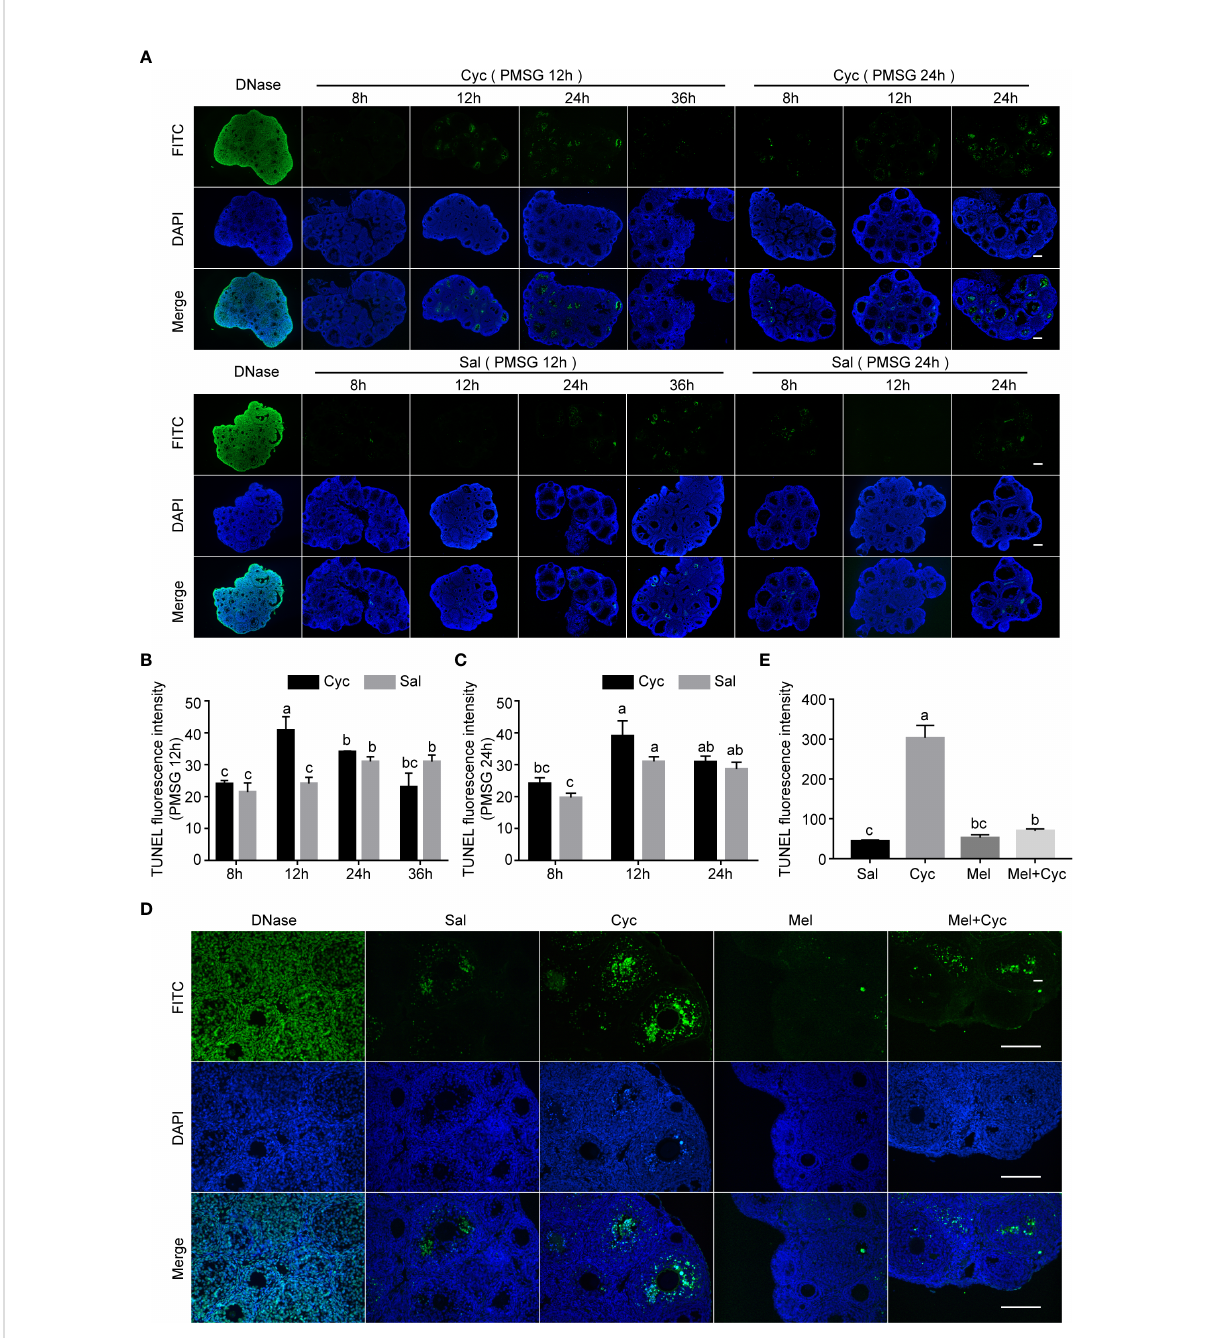
FIGURE 4 Cyc induced apoptosis of granulosa cells in growing follicles and Mel prevented this apoptosis. (A) Three-week-old ICR mice were injected i.p. with Cyc 12 or 24 h after injection of PMSG, and apoptosis in ovarian tissues was detected by TUNEL kit at 8, 12, 24, and 36 h after Cyc injection. Regardless of whether Cyc was injected 12 or 24 h after PMSG injection, apoptotic peak of granulosa cells in ovary appeared 12 h after Cyc intervention, which was not related to the time of PMSG administration. Mice in control group were injected with Sal instead of Cyc, and the apoptotic peak of granulosa cells appeared 48 h (PMSG 12 h + Sal 36 h, or PMSG 24 h + Sal 24 h) after injection of PMSG. DNase I treatment was used for positive control of TUNEL assay. There were four three-week-old female mice in each group; Bar = 200 m m. (B) TUNEL fl uorescence intensity in ovaries of 3-week-old ICR mice 8, 12, 24 and 36 hours after Cyc injection. The mice received Cyc chemotherapy 12 hours after injection of PMSG. (C) TUNEL fl uorescence intensity in ovaries of 3-week-old ICR mice 8, 12 and 24 hours after Cyc injection. The mice received Cyc chemotherapy 24 hours after injection of PMSG. (D) Mel prevented apoptosis of granulosa cells 12 h after Cyc chemotherapy. There were four three-week-old female mice in each group; Bar = 200 m m. (E) TUNEL fl uorescence intensity in ovaries of 3- week-old ICR mice in Sal, Cyc, Mel and Mel+Cyc groups 12 hours after Cyc